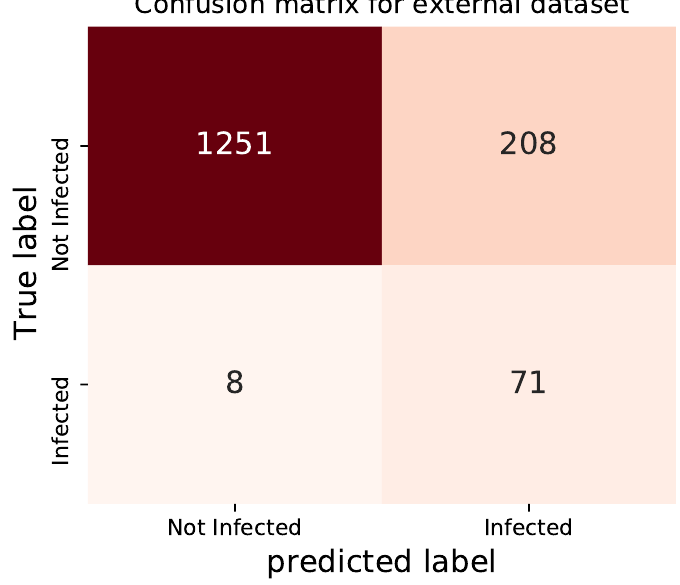
Figure 12. Confusion matrix for the external